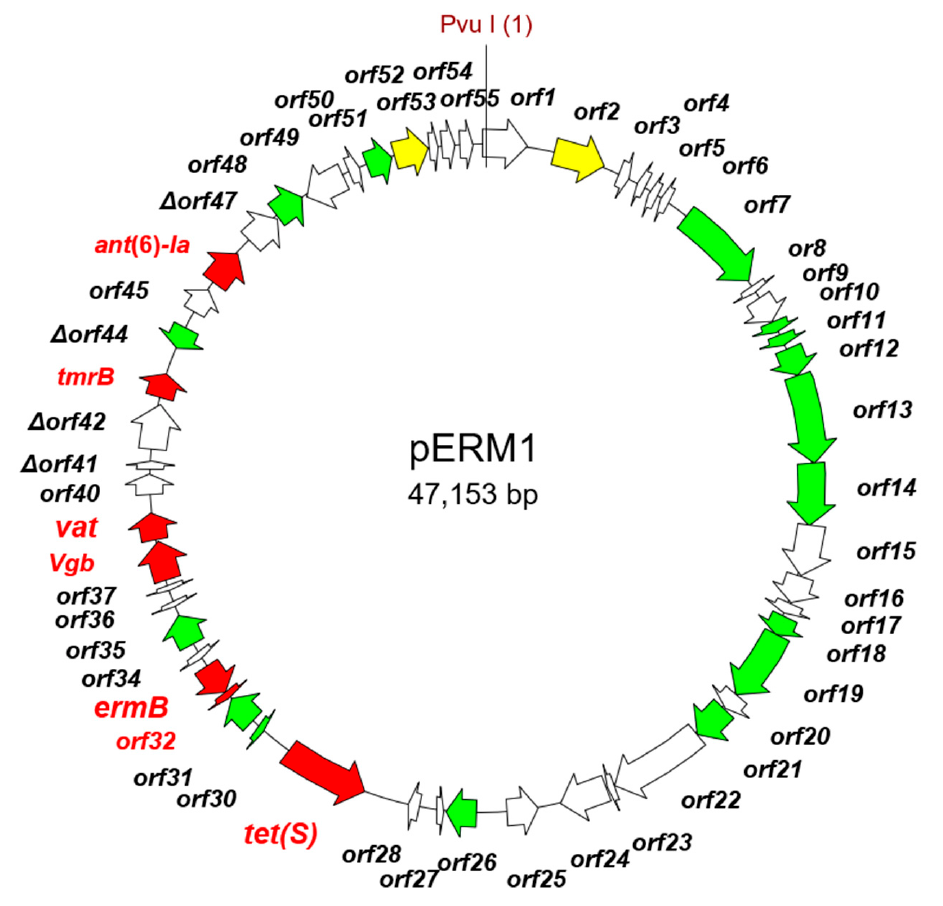
Figure 4. Genetic map of the erythromycin resistance plasmid pERM1 recovered in Lactococcus lactis . The position of ermB and other antibiotic resistance genes are highlighted in red. Plasmid features as in Figure 2.